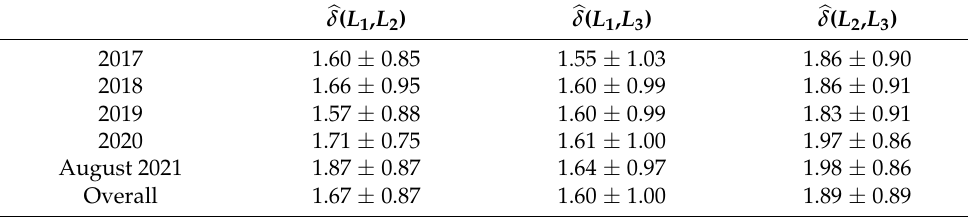
Table 1. ˆ δ ( L i , L i (cid:48) ) values.